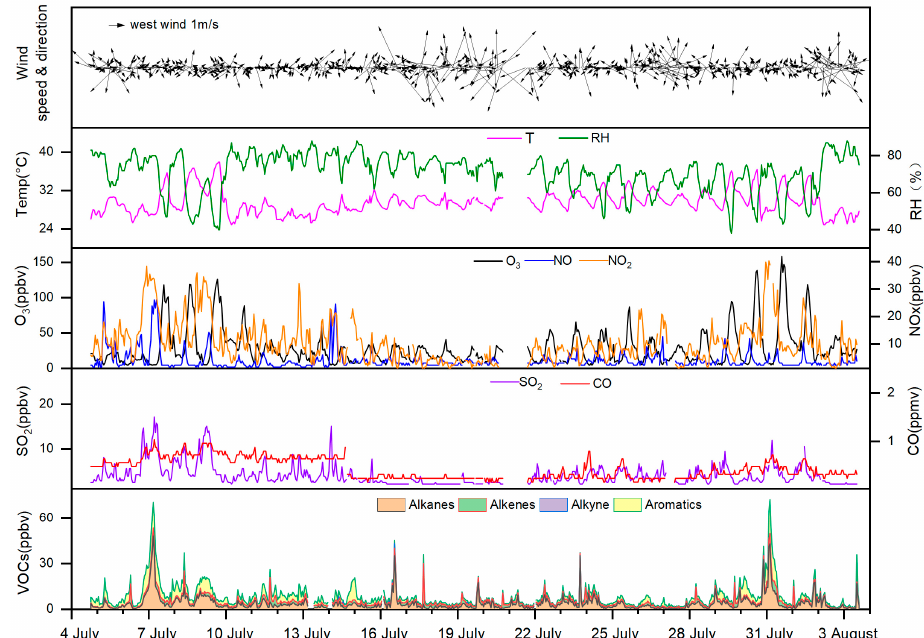
Figure 4. Time series of wind speed and direction, temperature (Temp) and relative humidity (RH), O 3 , NO, NO 2 , SO 2 , CO and VOCs concentrations at the WQS site.